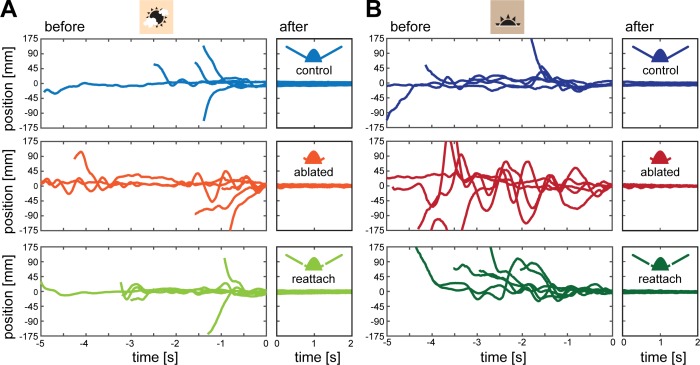
Hawkmoth flower approach.Flight tracks of hawkmoths approaching a stationary flower in bright (A, 3000 lux) and dim (B, 30 lux) light. Before refers to time intervals before their proboscis made contact with the nectary of the flower, after to the period after contact was initiated.